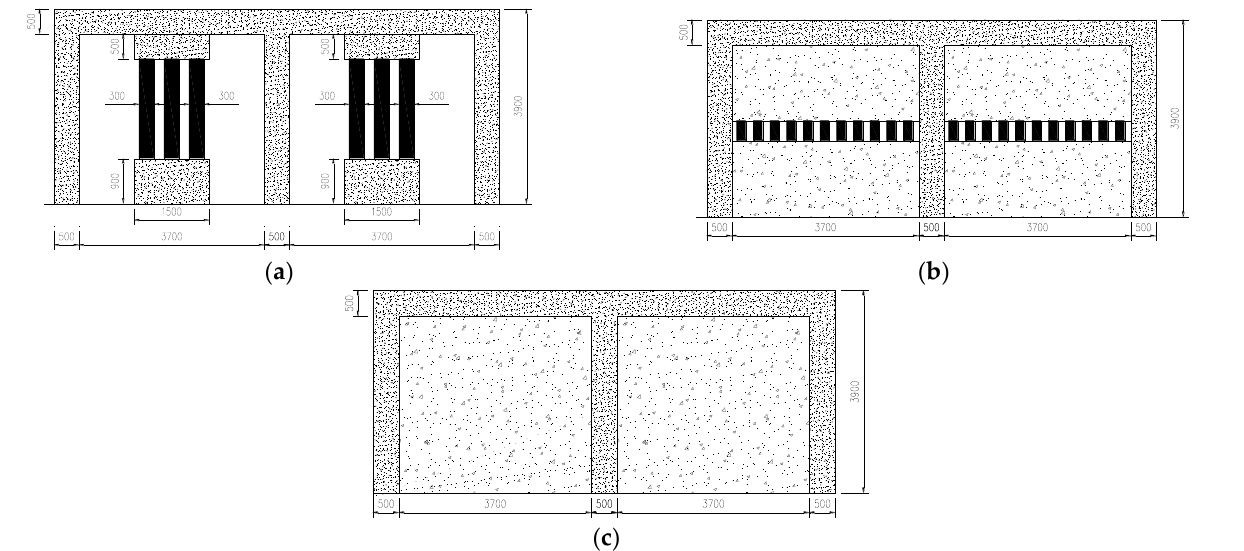
Figure 16. Elevation layouts of the first story. ( a ) JG-1; ( b ) JG-2; ( c ) JG-3.